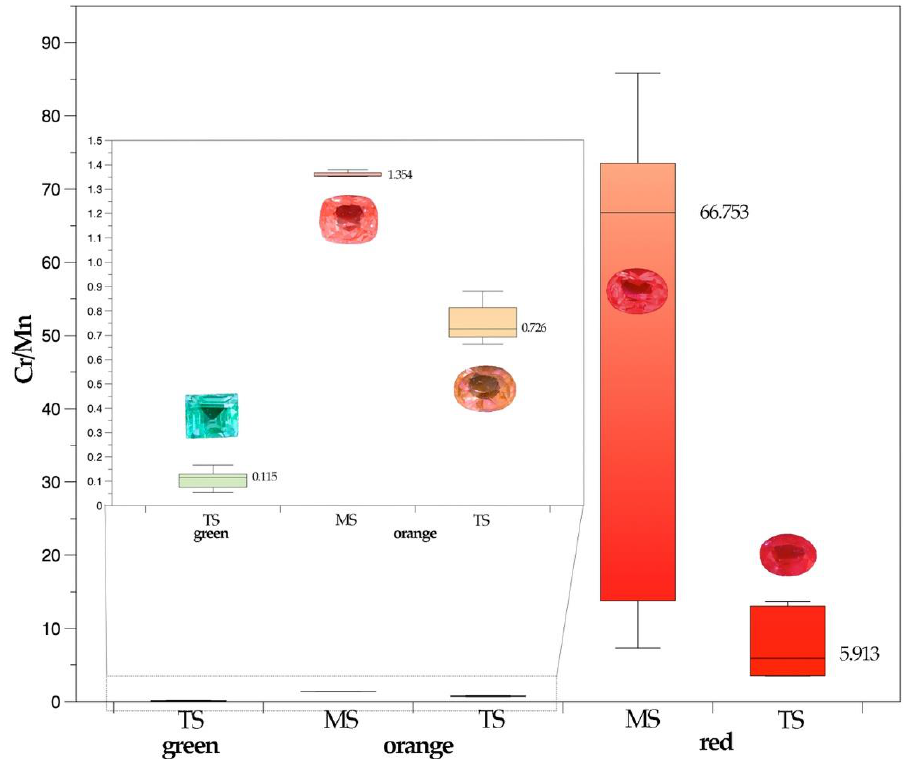
Figure 18. The relationship between Cr/Mn ratio and fluorescence with various colors. The values in the figure are the average value of each group. The values of the Cr/Mn ratio from high to low in order are red, orange, and green fluorescence. In addition, the Cr/Mn ratios of orange and red fluorescence are apparently higher in Myanmar samples.